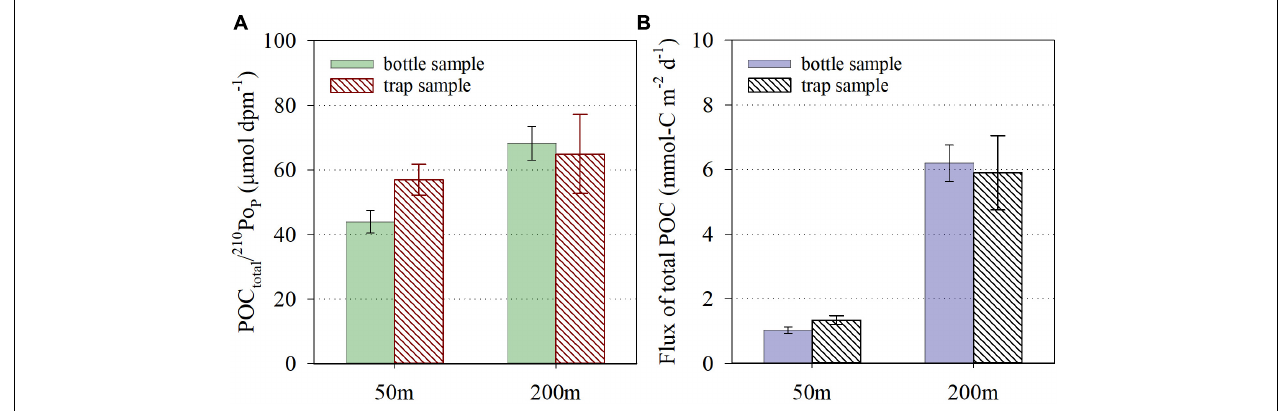
FIGURE 4 | Comparisons in the POC/ 210 Po ratio (A) and estimated total POC flux using 210 Po (B) between bottle-sampling TPM and sediment trap-collected particles at 50 and 200 m.